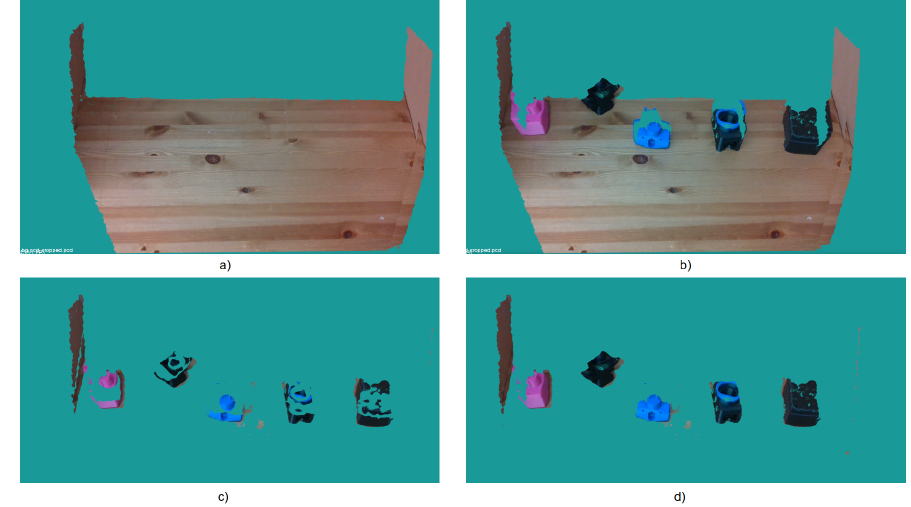
Figure 6. ( a ) Background point cloud, ( b ) Scene point cloud, ( c ) Background subtraction without adding background to scene, ( d ) Background Subtraction after adding background to